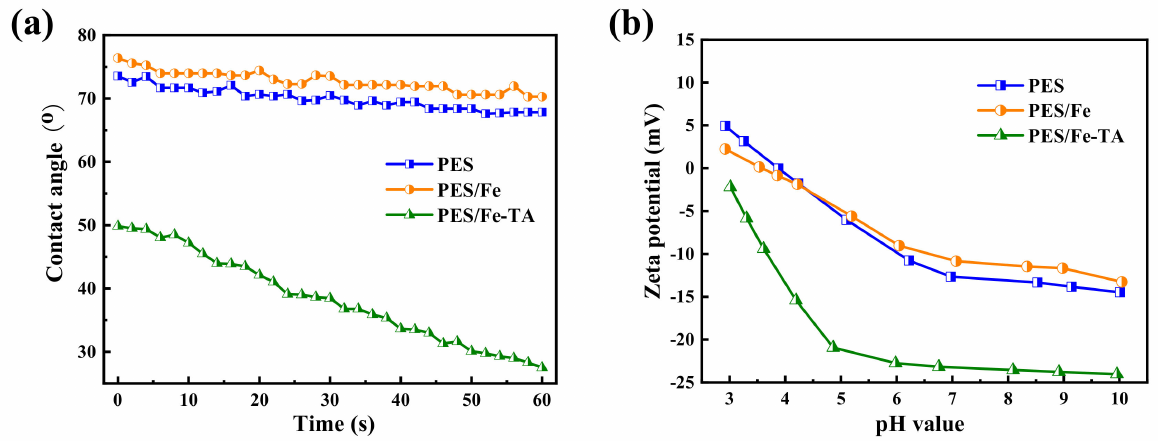
Figure 4. ( a ) The water contact angle and ( b ) zeta potentials of the PES, PES/Fe and PES/Fe-TA